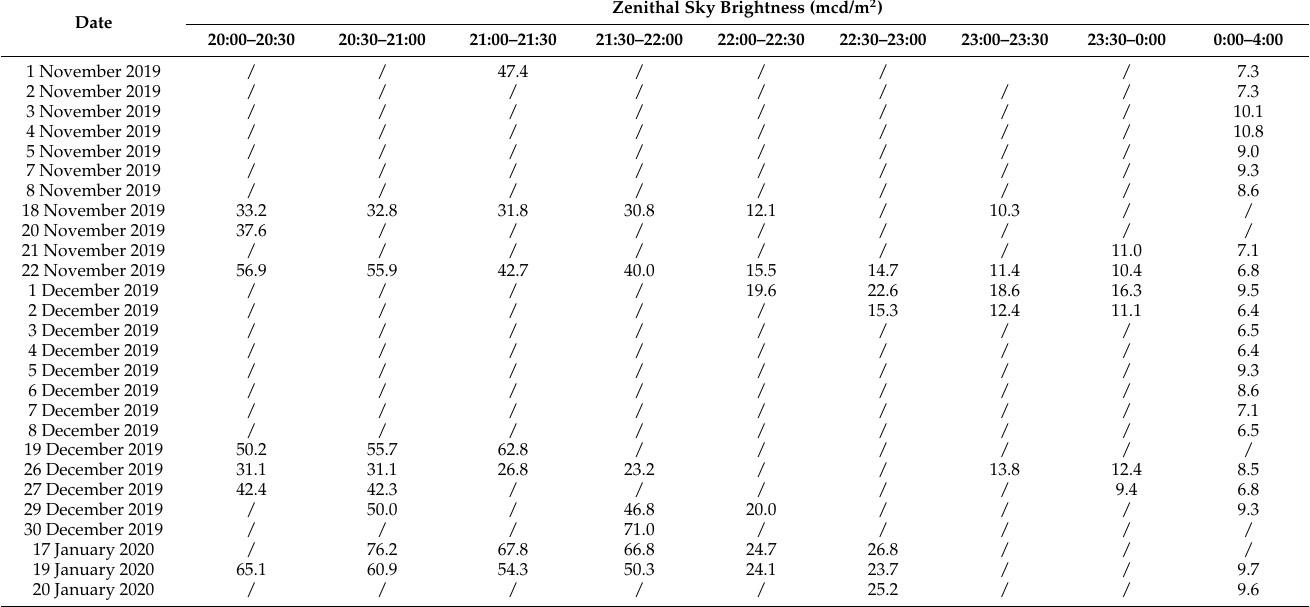
Table 3. The daily ZSB values at all time intervals from 1 November 2019 to 11 April 2020. Note that the dates of ZSB values after midnight are advanced by one day to maintain temporal consistency, which means the ZSB value at the 0:00–4:00 time interval of 1 November in Table 3 was recorded at the dawn of 2